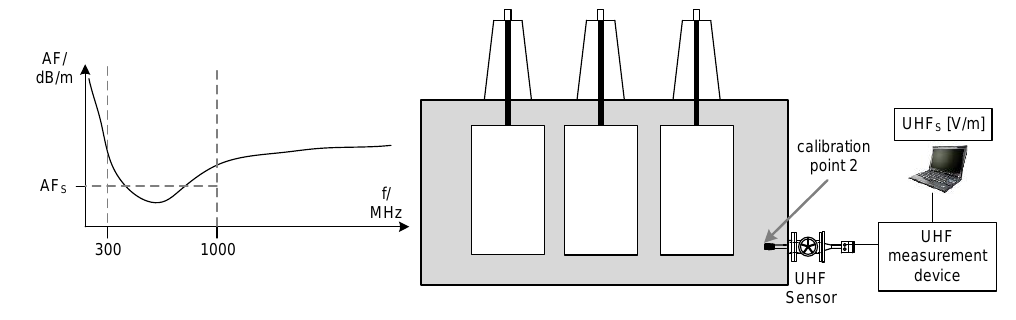
Figure 6. Calibration of the UHF sensor.